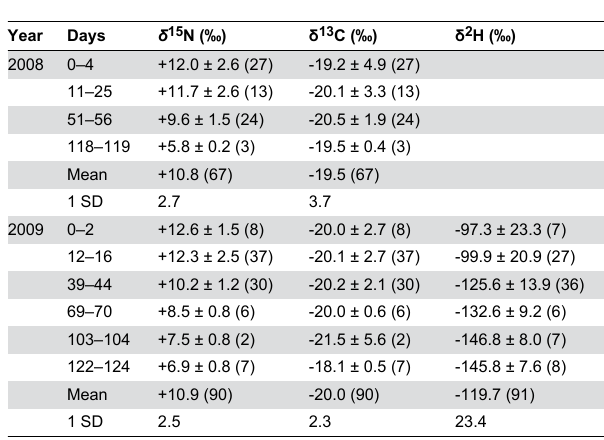
Table 1. Isotopic composition ( x , 1 SD; n in parentheses) of claw tips for Lesser Scaup ( Aythya affinis ) sampled at Red Rock Lakes National Wildlife Refuge, Montana, USA, 2008 and